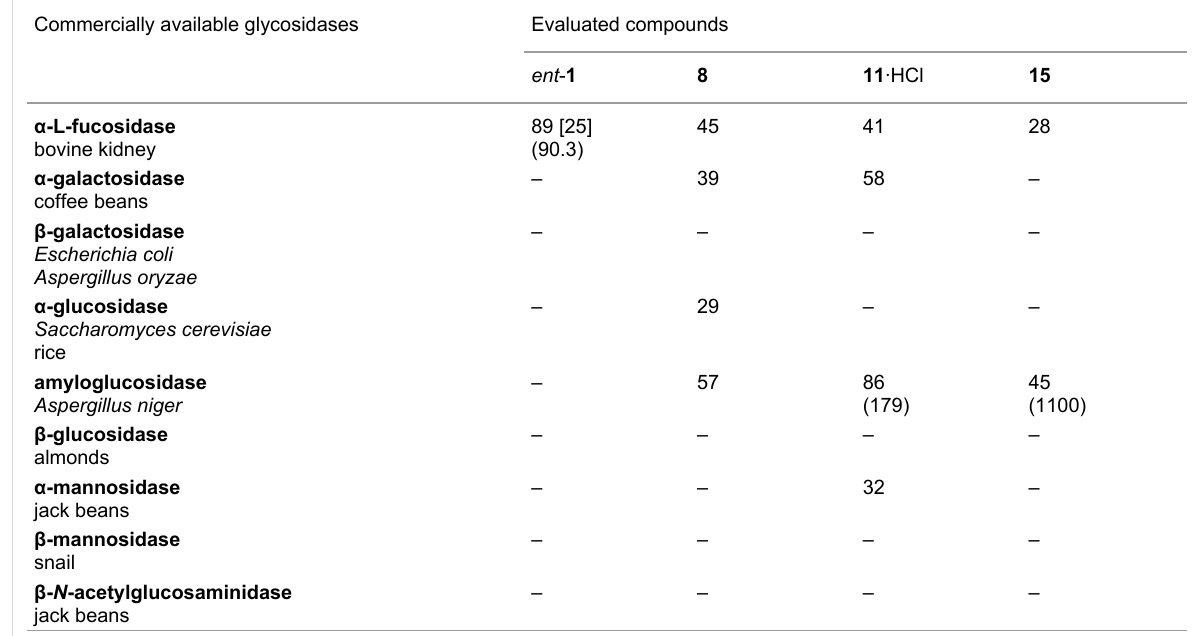
Table 1: Inhibitory activity of compounds ent - 1 , 8 , 11 . HCl, 15 towards glycosidases. Percentages of inhibition at 1mM of inhibitor (IC 50 in parentheses [µM]) were